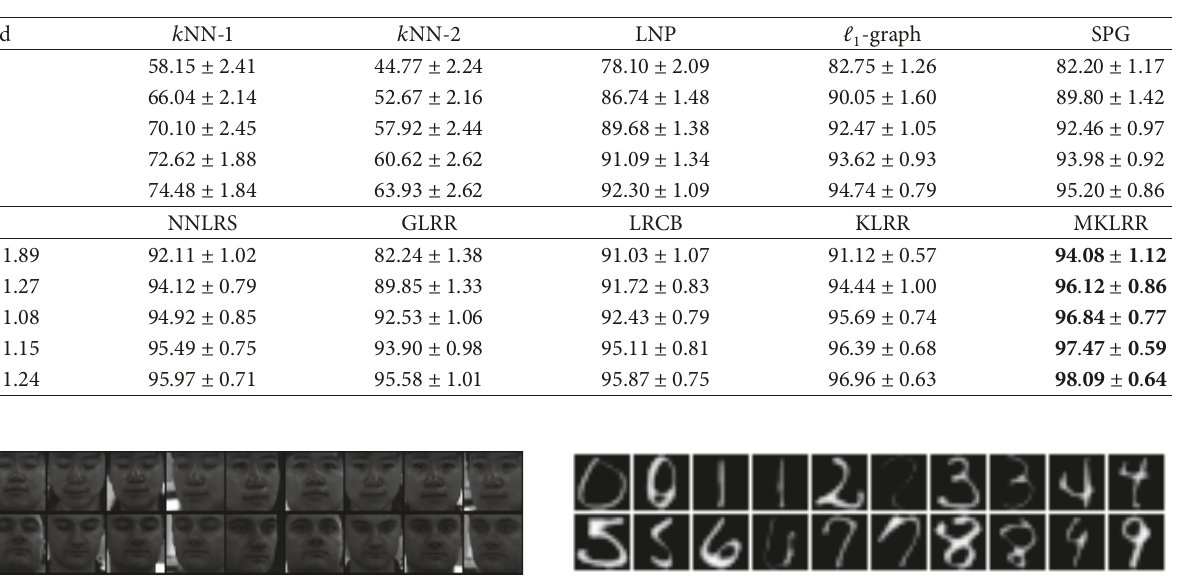
Table 3: Classification accuracies (%) of different algorithms with different number of labeled samples on the Extended Yale B data set.